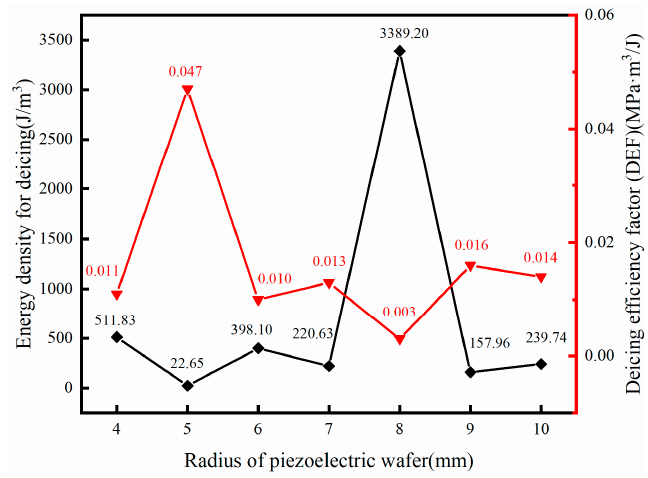
Figure 9. Energy density needed for deicing and deicing efficiency factor (DEF) of seven different configurations.